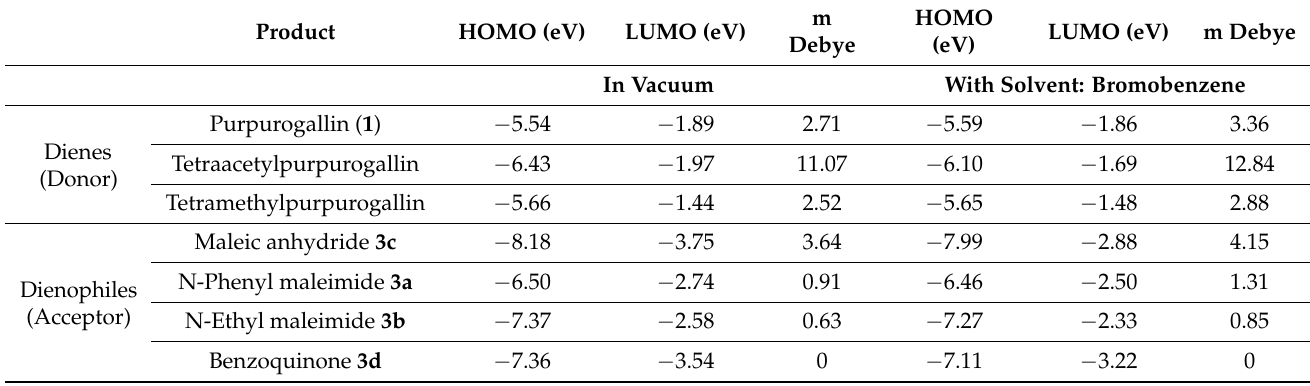
Table 2. Frontier orbitals calculated.